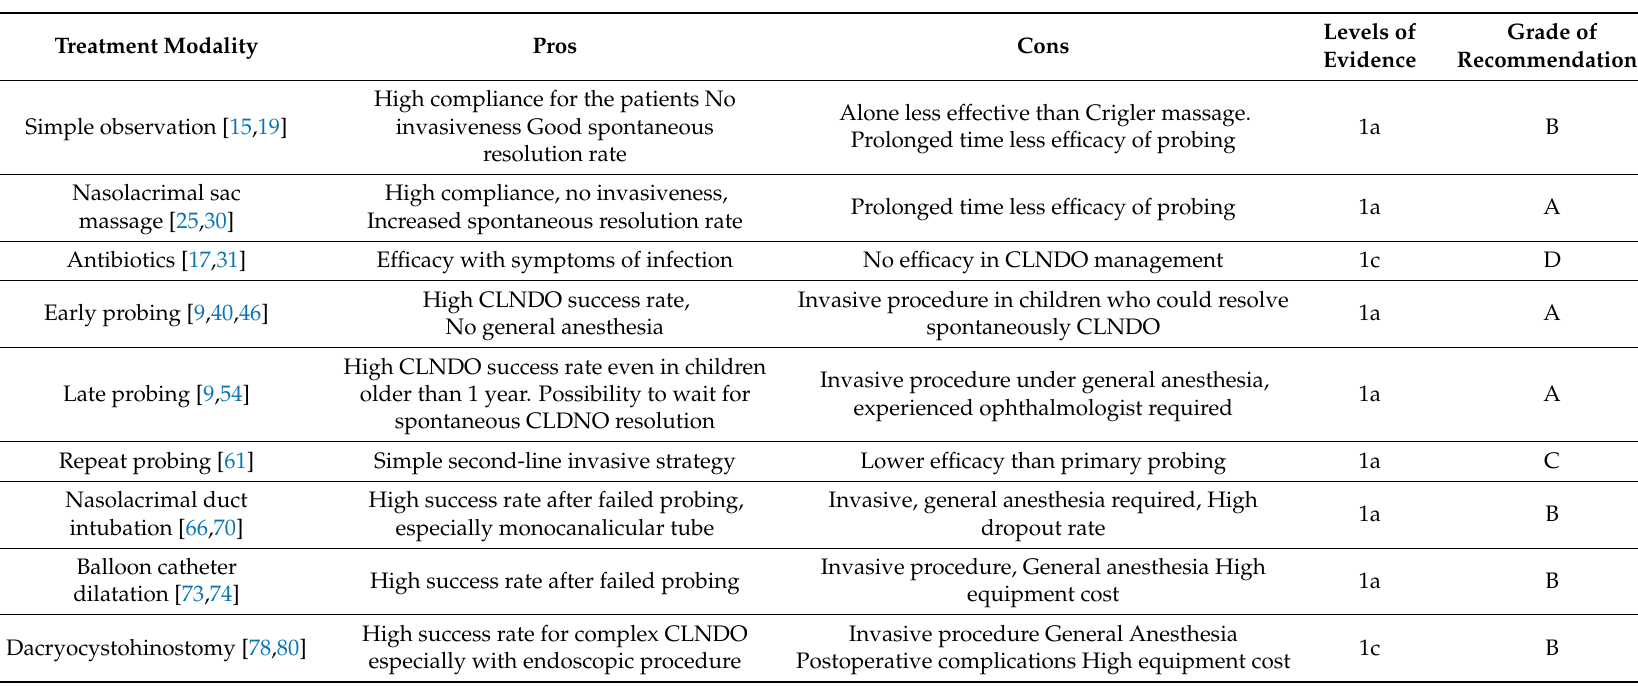
Table 1. Clinical efficacy comparison between the treatment modalities in the management of congenital nasolacrimal duct obstruction (CLNDO) following the criteria set by Oxford-Centre for level of Evidence-Based medicine and grade of recommendations Assessment, Development and Evaluation